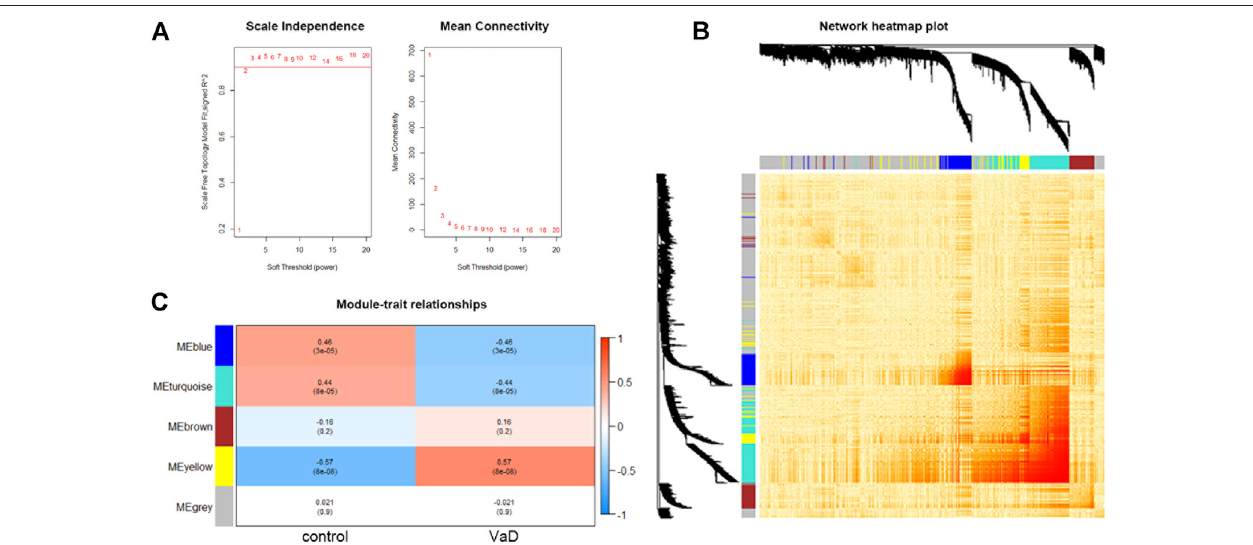
FIGURE 1 | Results and visualization of Weighted Gene Co-expression Network Analysis (WGCNA) analysis. (A) Determination of soft threshold β . Left: scale independence; right: mean connectivity. (B) Heat map showing the TOM among all 5,000 genes involved in the WGCNA with cluster dendrogram showing on the axis. Each color represents one speci fi c co-expression module; the above branches represent genes. The genes with strong correlations are clustered into modules, which are represented as dark sections symmetrically distributed along the diagonal in the heatmap, corresponding to the cluster dendrogram. (C) Module – trait relationships among the fi ve gene modules. The yellow module is the most correlated module (correlation coef fi cient = 0.57, *** p < 0.001).